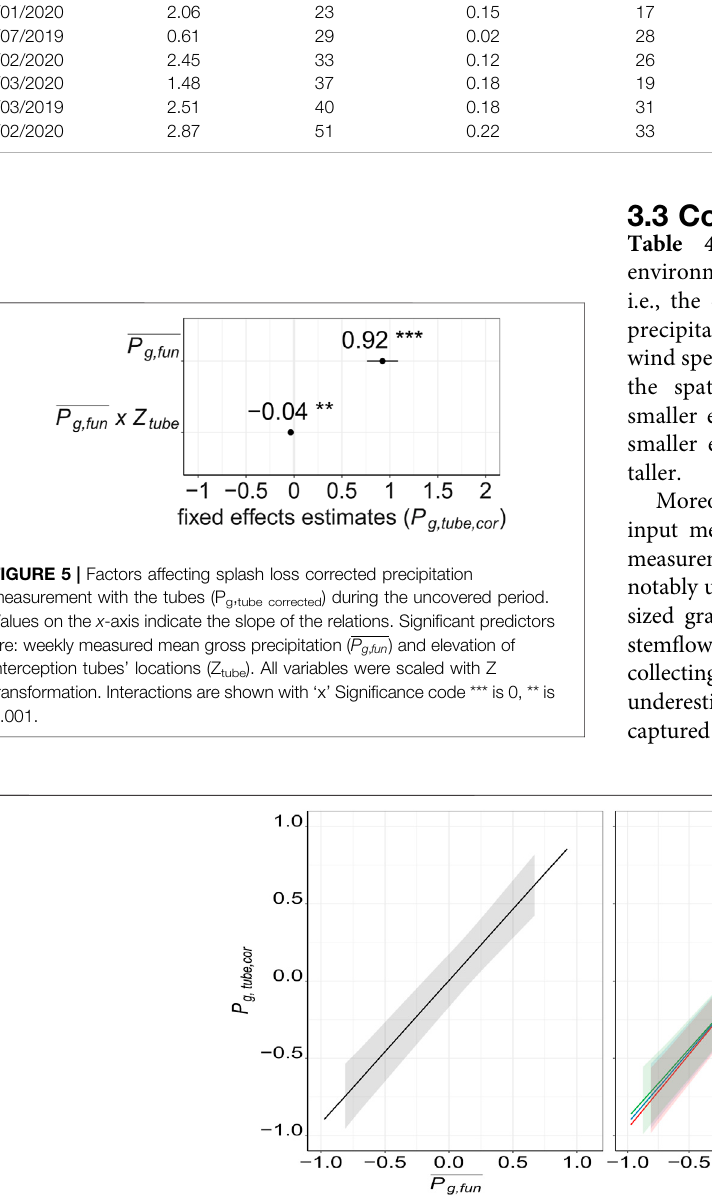
FIGURE 6 | Visualisation of the signi fi cant relations shown in Figure 5 , representing the signi fi cant drivers of corrected tube gross precipitation measurements (P g,tubes,cor ) during the uncovered period. Relation to (left) mean gross precipitation ( P g , fun ), (right) Interactive relation of mean gross precipitation ( P g , fun ), with elevation of the tubes locations Z tube .